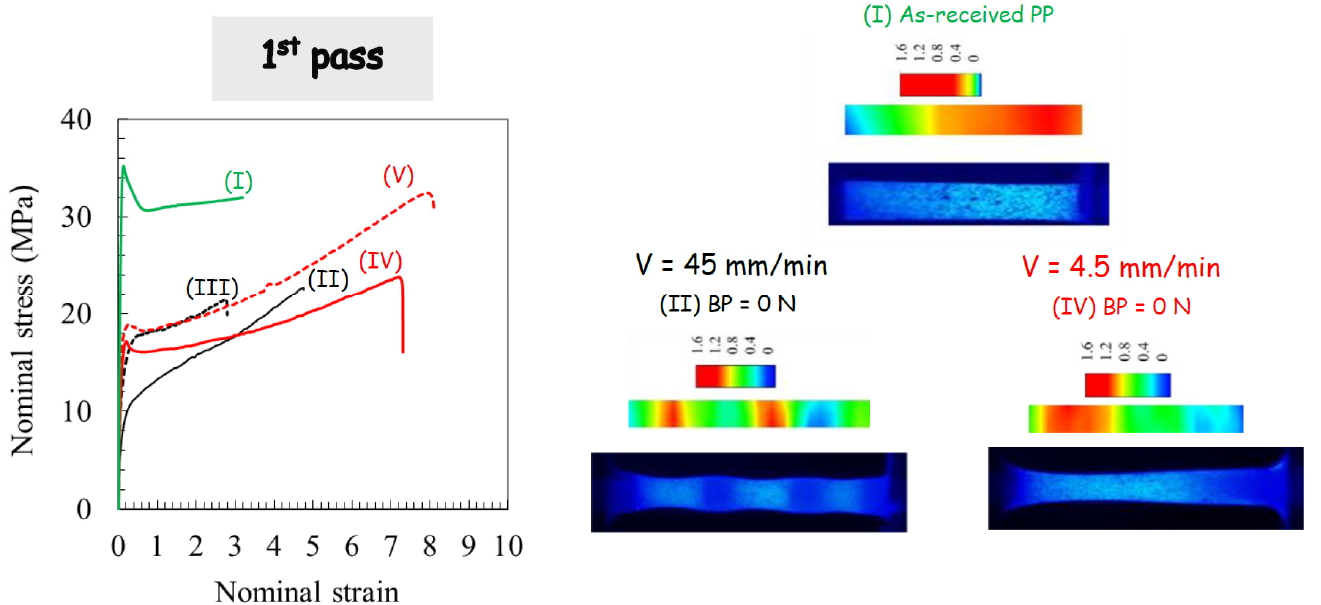
Figure 8. Tensile results after first pass extrusion in terms of stress-strain curve, deformation behavior and strain localization for different processing parameters: ( I ) as-received material, ( II ) ram velocity of 45 mm/min and BP of 0 N, ( III ) ram velocity of 45 mm/min and BP of 900 N, ( IV ) ram velocity of 4.5 mm/min and BP of 0 N, and ( V ) ram velocity of 4.5 mm/min and BP of 900 N.